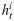
Structure of the rnn model.The model has an lstm layer (shown by red dashed line) which receives the previous action and reward as inputs, and is connected to a softmax layer (shown by a black rectangle) which outputs the probability of selecting each action on the next trial (policy). The lstm layer is composed of a set of lstm cells (Nc cells shown by blue circles), that are connected to each other (shown by green arrows). The outpt of the cells (denoted by hti for cell i at time t) are connected to a softmax layer using a set of connections shown by black lines. The free parameters of the model (in both lstm and softmax layers) are denoted by Θ, and L(Θ,rnn) is a metric which represents how well the model fits subjects’ data and is used to adjust the parameters of the model using the maximum-likelihood estimate as the network learns how humans learn.